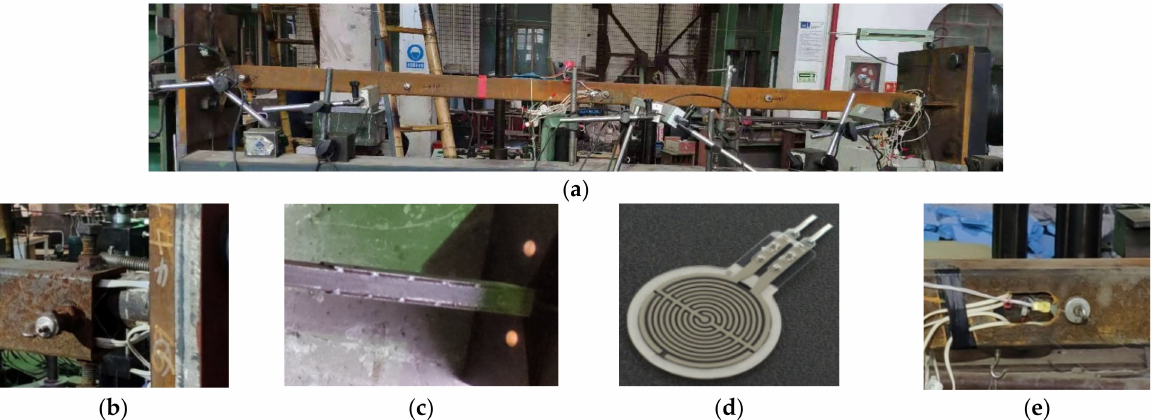
Figure 3. Some details of the specimen: ( a ) Overall view of specimen; ( b ) connection bolts at the restraining tube ends; ( c ) reinforcing plates welded on the core tube with spot welding; ( d ) pressure sensor; ( e ) punching a hole into the restraining